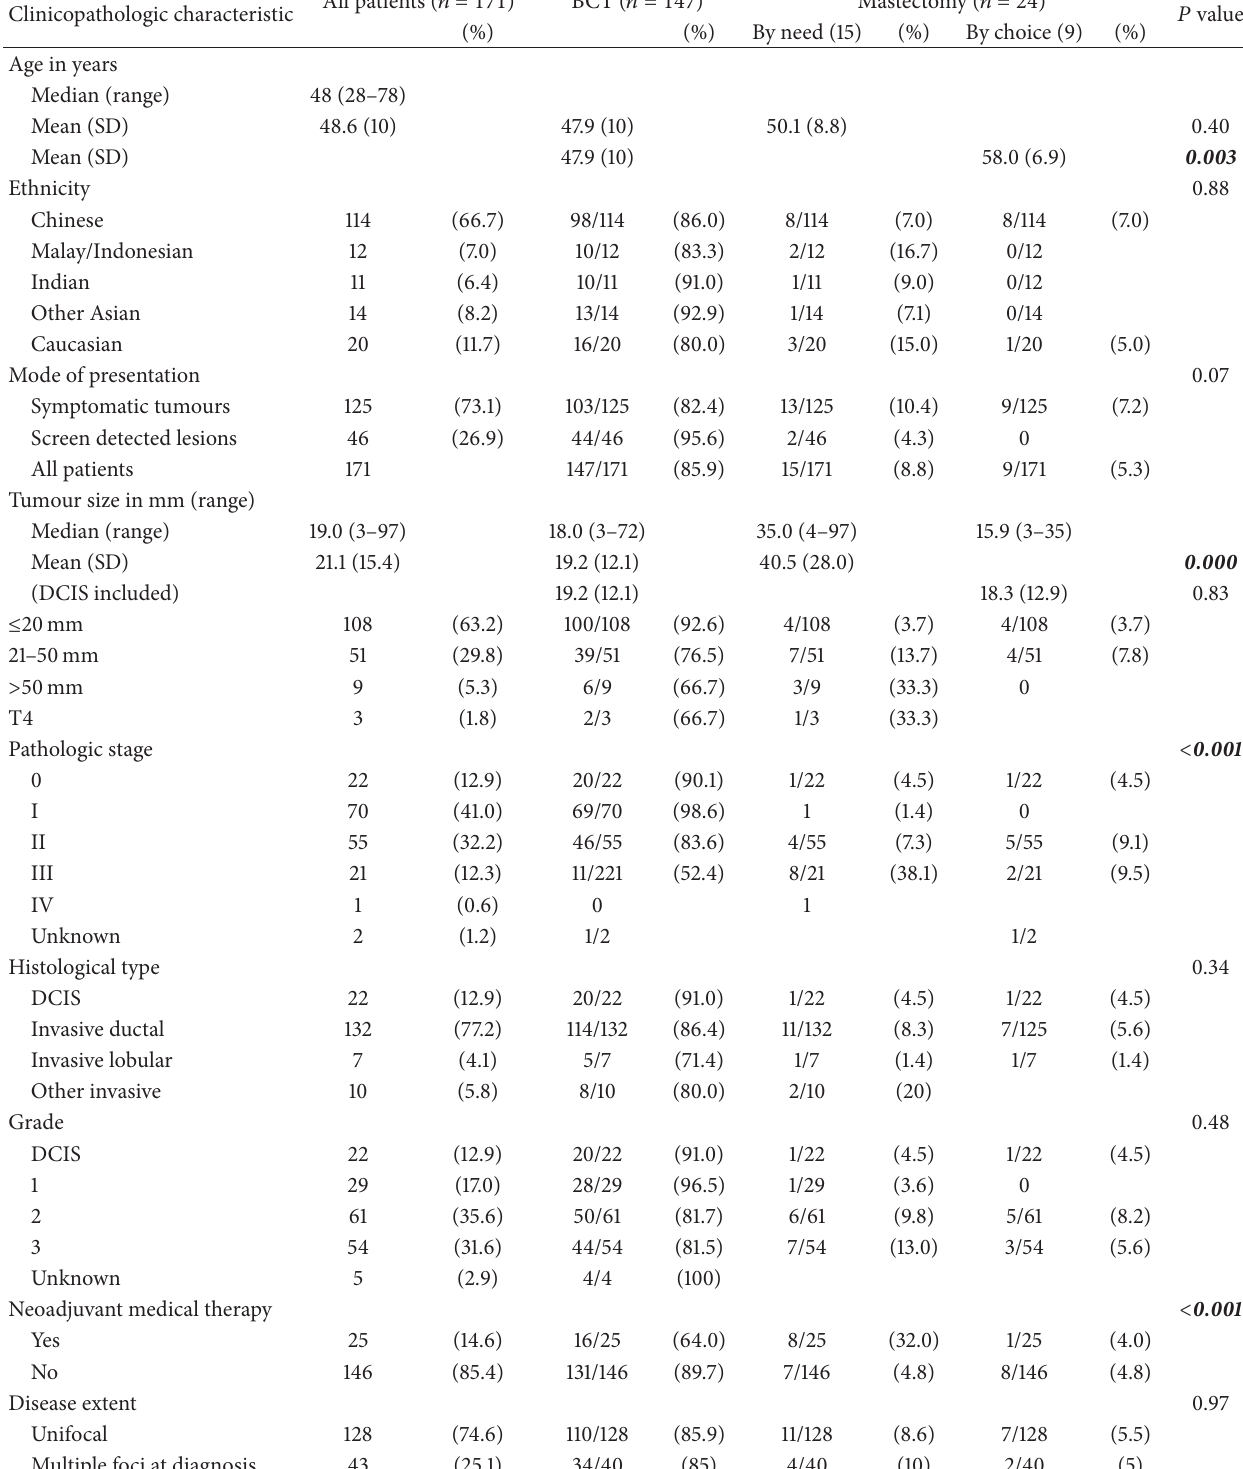
Table 2: Summary of demographic, clinicopathologic, and outcome data for study